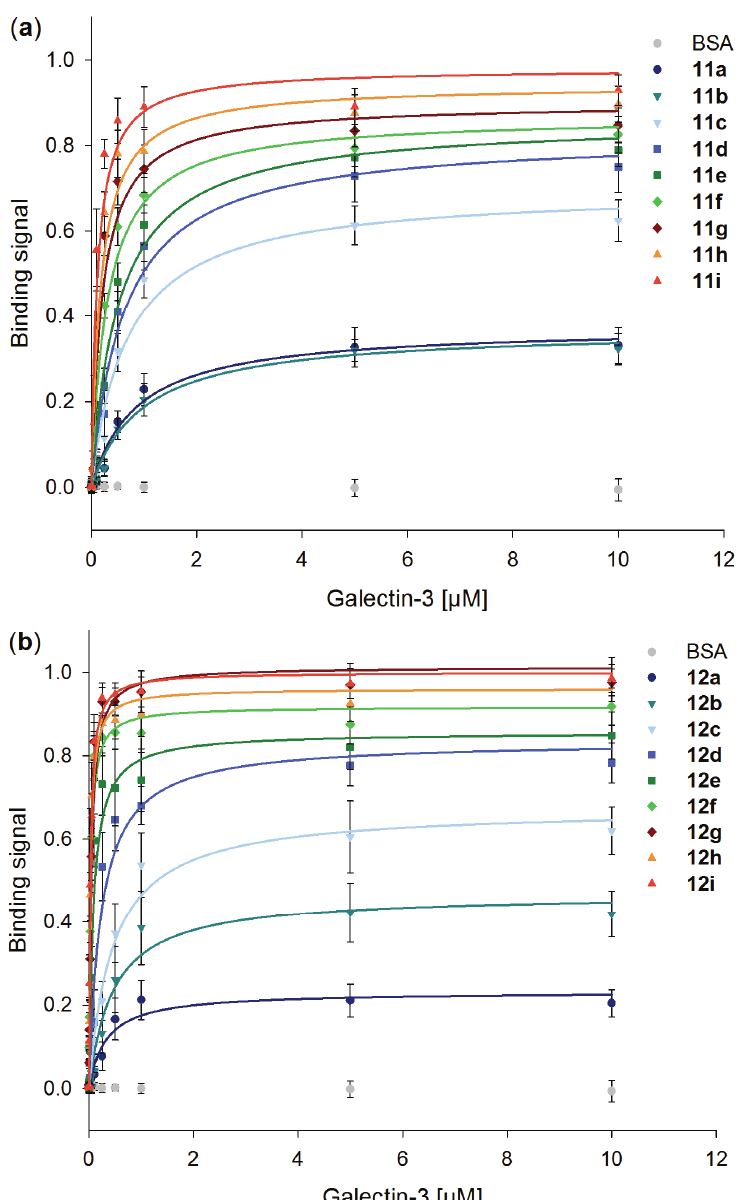
Figure 3. Binding of human galectin-3 to different neo-glycoproteins. Different amounts of galectin-3 were incubated on immobilized neo-glycoproteins (5 pmol per well) presenting ( a ) LacNAc-LacNAc ( 11a – i ) and ( b ) LacDiNAc-LacNAc ( 12a – i ) in an ELISA-type assay. Binging signals are plotted against galectin-3 concentration. The curves were fitted using Sigma Plot